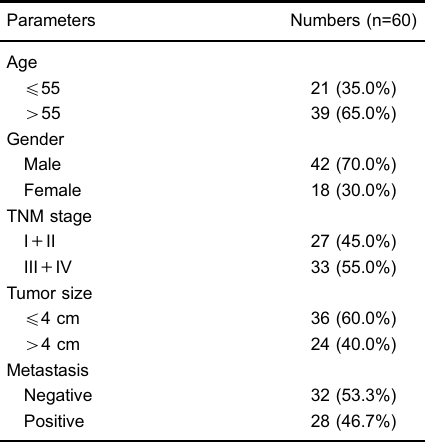
Table 1. Clinicopathological features of the hepatocellular carcinoma